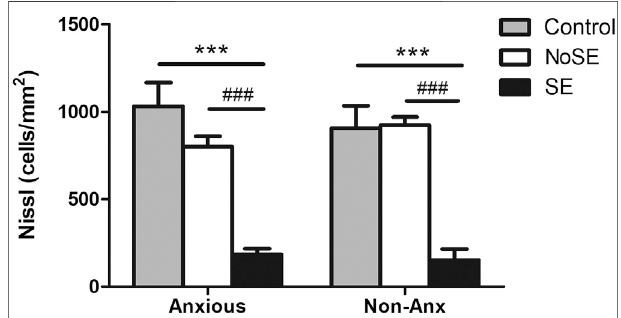
FIGURE 2 | Density of neuronal cells in the hilus 90 days after pilocarpine injection. SE animals presented decreased neuronal density as compared to controls and NoSE animals in both Anx and Non-Anx groups. Control animals and NoSE animals, in both Anx and Non-Anx groups, showed similar amounts of cells. Values: mean ± SEM. Two-Way ANOVA, Bonferroni post hoc test, Seizure p < 0.05 *vs Controls, #vs NoSE; Anxiety p > 0.05; Interaction p >